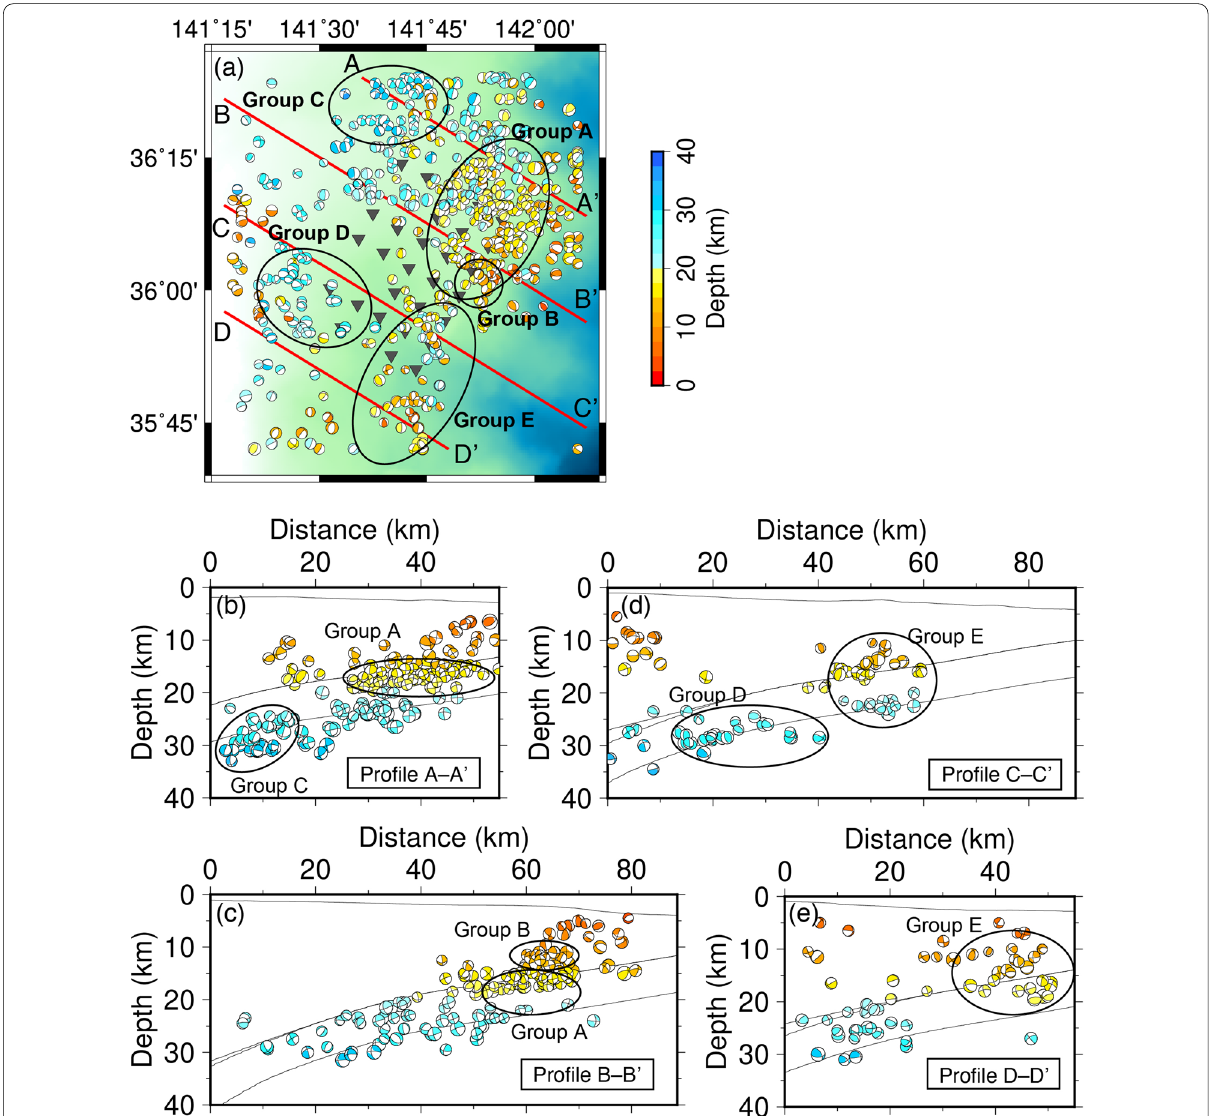
Fig. 6 a Spatial distribution of the obtained CMT solutions. The color of the focal mechanisms shows their depth. b–e Cross sections with the profiles of A–A’, B–B’, C–C’, and D–D’, respectively. The thin lines show the bathymetry, the upper surface and oceanic Moho of the Pacific Plate, and the upper surface of the Philippine Sea Plate (Koketsu et al.